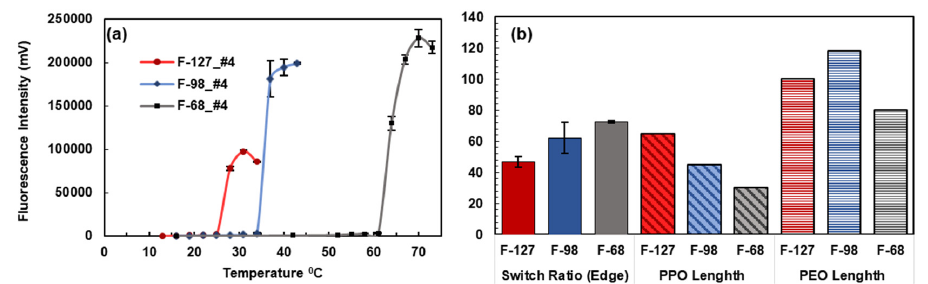
Figure 5. ( a – f ) Response of Pluronic F-127 loaded with fluorophores to the change in temperature. Black arrows show the LCST and red arrows the first local maximum (major slope change in the case of a plateau). ( g ) Pluronic F-127 nanoparticles loaded with fluorophore 4 acted as a very strong switch. Both F-127 nanoparticles loaded with fluorophore 2, 3 and 5, act as moderate switches. F-127 nanoparticles loaded with fluorophore 1, and 6 did not qualify as a switch due to having a large T BW ( ≥ 15 °C). (Values are based on Edge method).